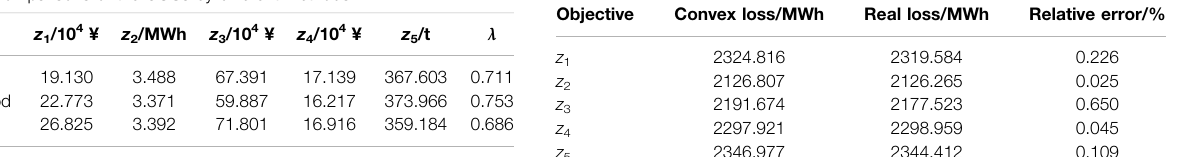
TABLE 5 | Comparison of convex and real loss of the